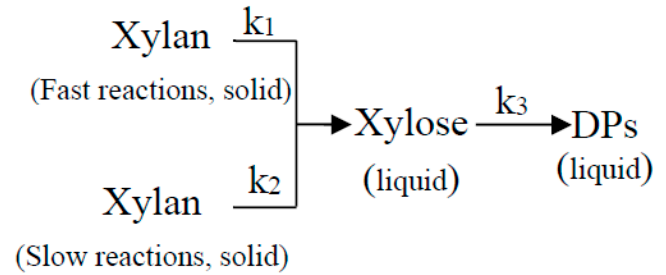
Scheme 2. The reaction process of xylan involved in the two-phase model.